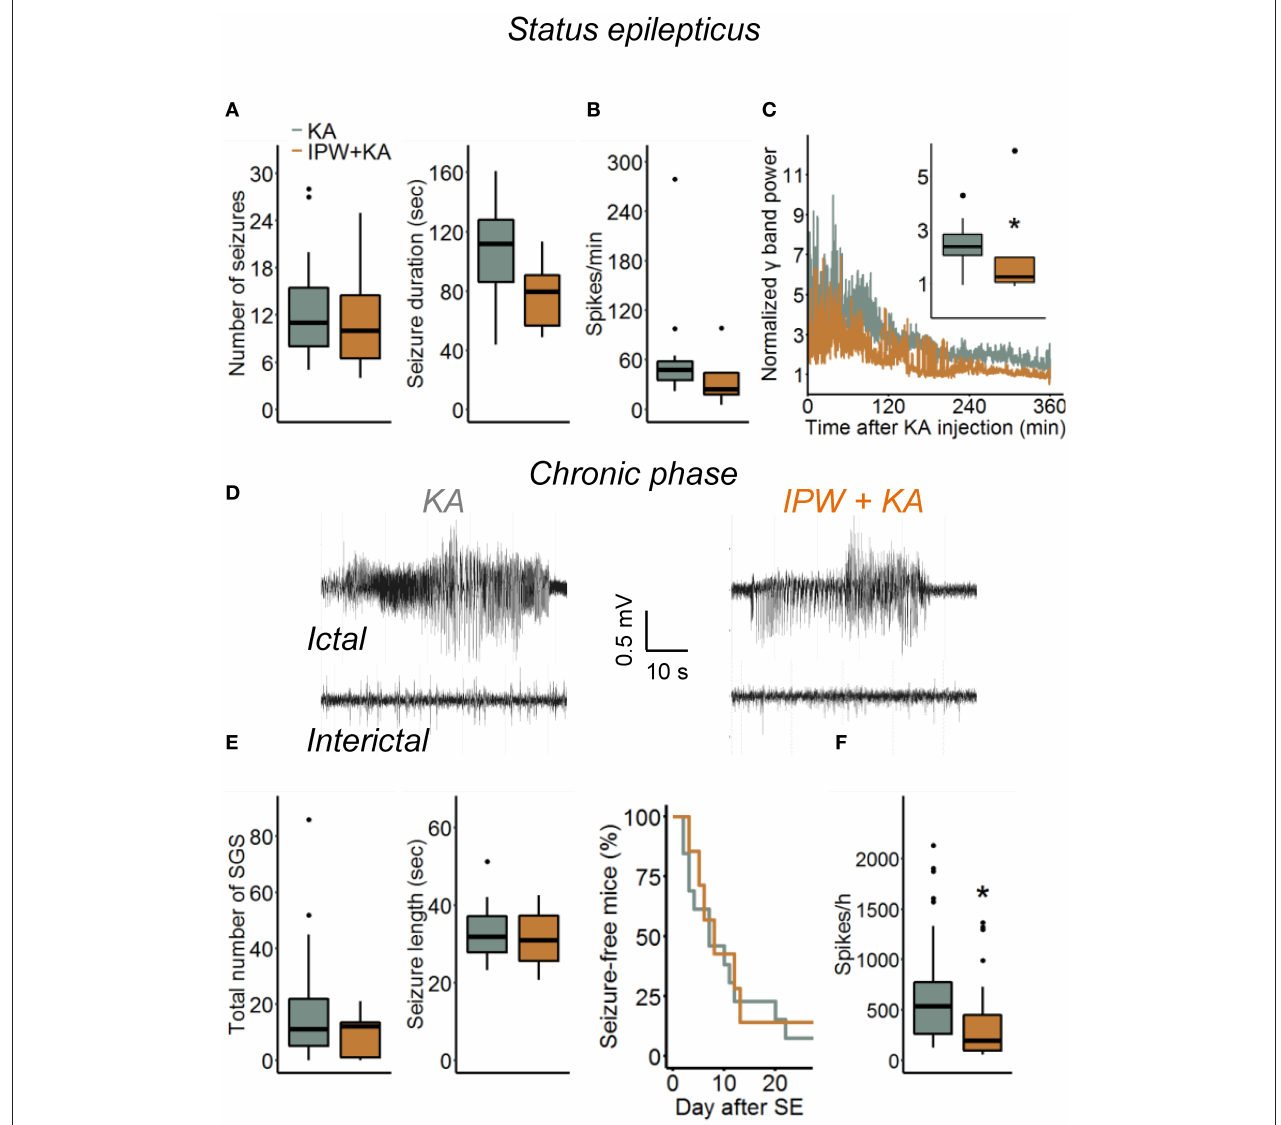
FIGURE 4 | Kainate-induced acute and chronic epileptiform activity in IPW-5371-pretreated mice. (A) Number and duration of seizures during the first hour of kainate-induced SE did not differ between IPW-5371- and vehicle-treated kainate mice. (B) Severity of SE determined by counting the number of EEG spikes exceeding 7.5-fold baseline activity during the first 6h after kainate injection. Spike activity was not affected by IPW-5371. (C) Spectral analysis yielded significantly lower γ band power in IPW-5371- vs. vehicle-treated kainate mice. (D) Representative EEG traces depicting spontaneous generalized seizures ( ictal ) and interictal spiking activity ( interictal ) in IPW-5371-treated and control mice. (E) Total number and length of spontaneous generalized seizures (SGS) in IPW-5371- and vehicle-treated kainate mice. Neither the number nor the length of SGS was significantly different between the experimental groups (left graph). The length of the latent phase was also similar in both groups (right graph). (F) The number of spikes/hour during the entire 4 weeks of recording was slightly but significantly reduced in IPW-5371- vs. vehicle-treated kainate mice. Box plots represent median and quartiles. * p < 0.05 (independent samples t -test) . N = 7 (kainate + IPW-5371) and 13 (kainate) mice. KA,